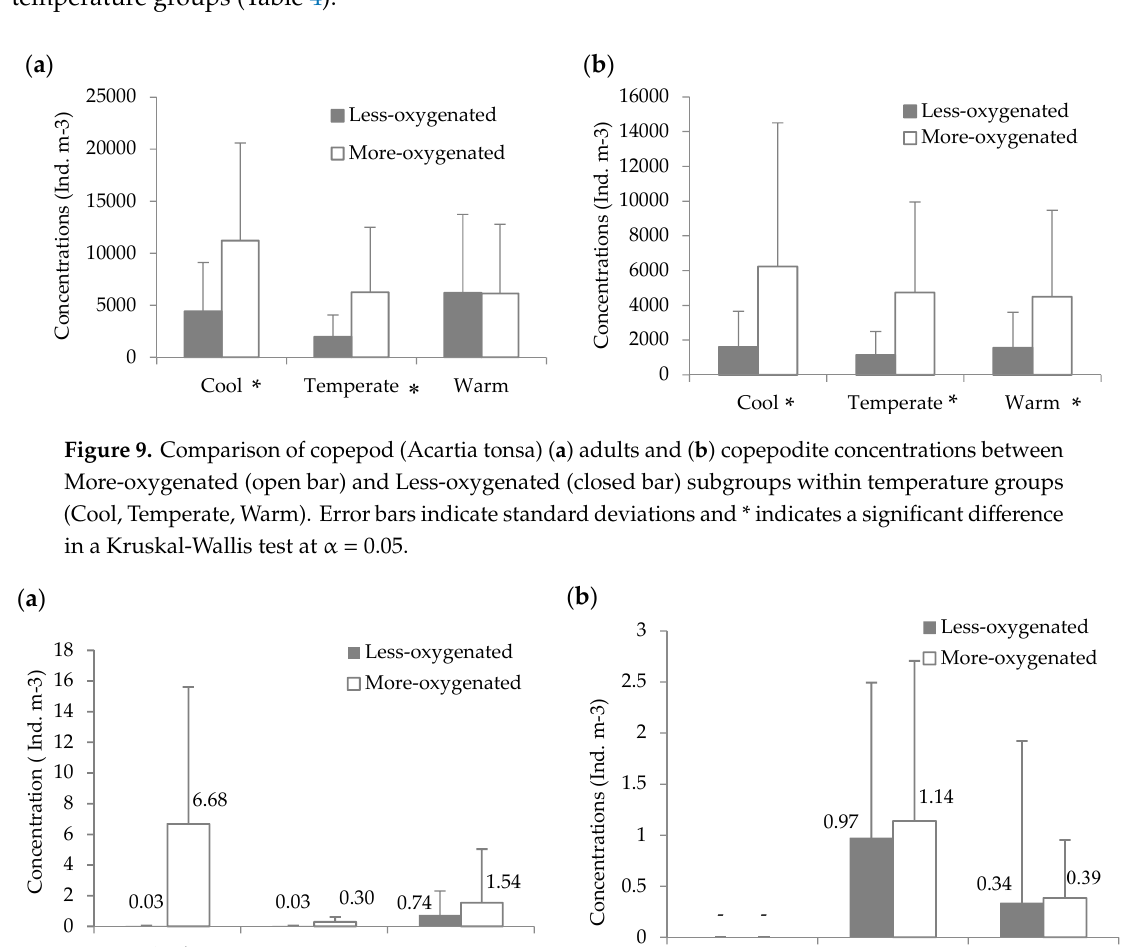
Figure 11. Comparison of ( a ) ctenophore ( Mnemiopsis leidyi) and ( b ) bay nettle ( Chrysaora chesapeakei ) concentrations between More-oxygenated (open bar) and Less-oxygenated (closed bar) subgroups within temperature groups (Cool, Temperate, Warm). Numbers indicate average concentrations, error bars indicate standard deviations, and * indicates significant differences in a Kruskal-Wallis test at α = 0.05. Table 4. The Kruskal-Wallis test on differences in concentrations of zooplankton and fish between the more-oxygenated (MO) and less-oxygenated (LO) subgroups within the cool (C), temp (T), and warm (W) groups.